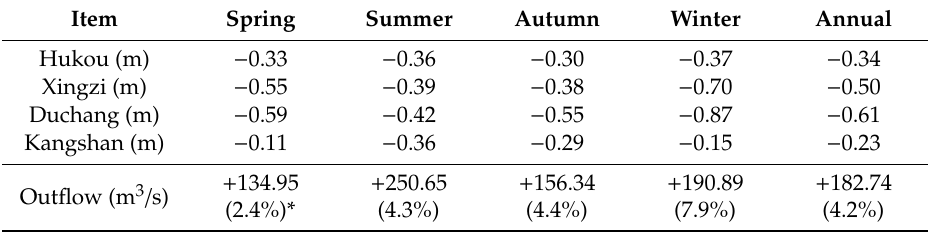
Table 2. Average changes of seasonal and annual lake level and outflow.